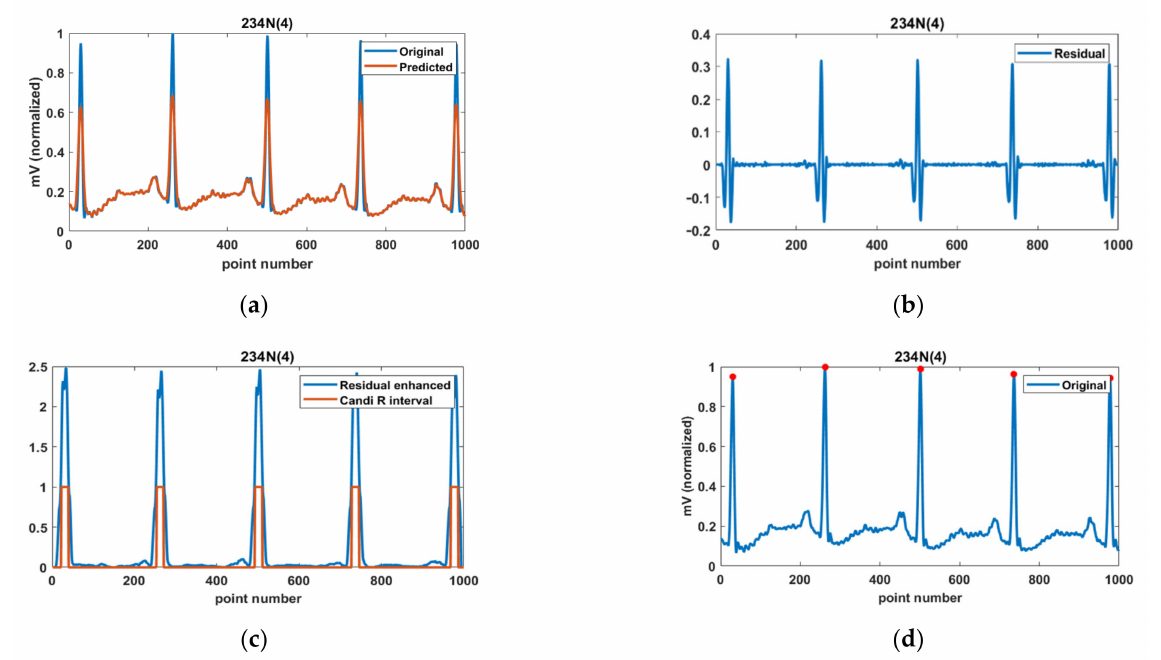
Figure 5. Detection procedure of the R-peak; ( a ) predicted background signal, ( b ) residual (difference) signal, ( c ) candidate-R interval, and ( d ) detected